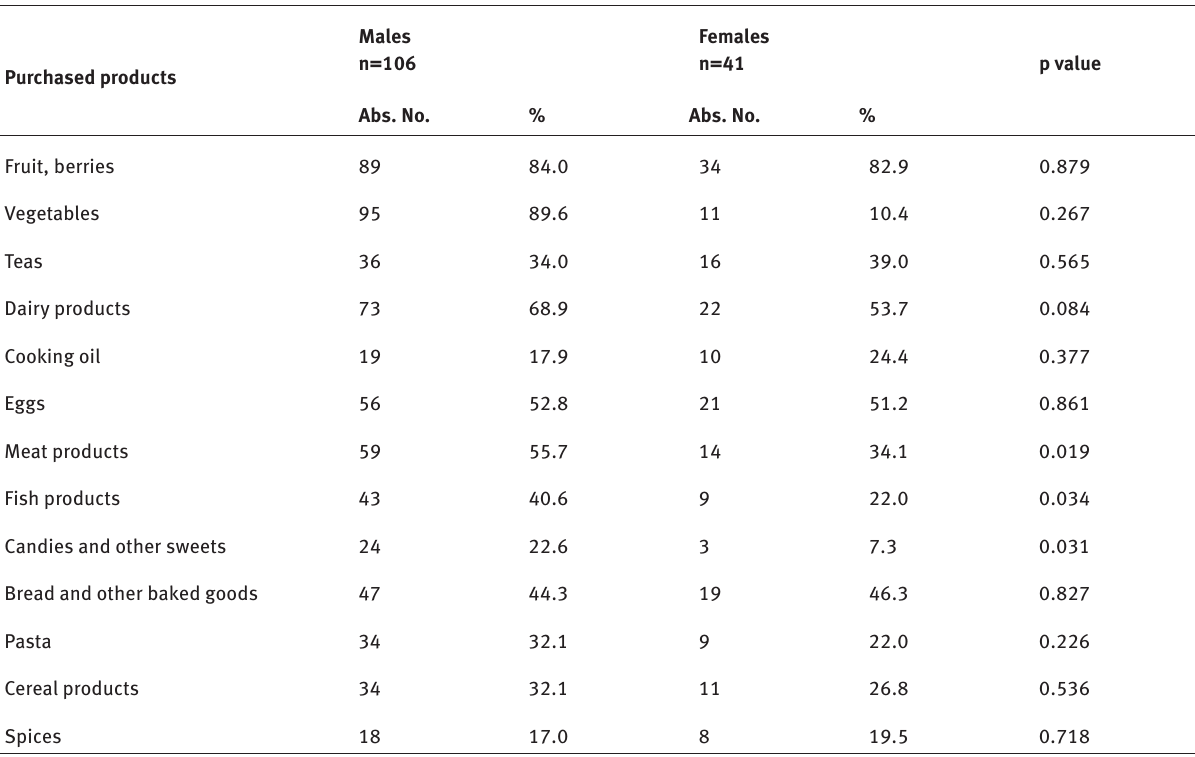
Table 3: Distribution of organic food products by income